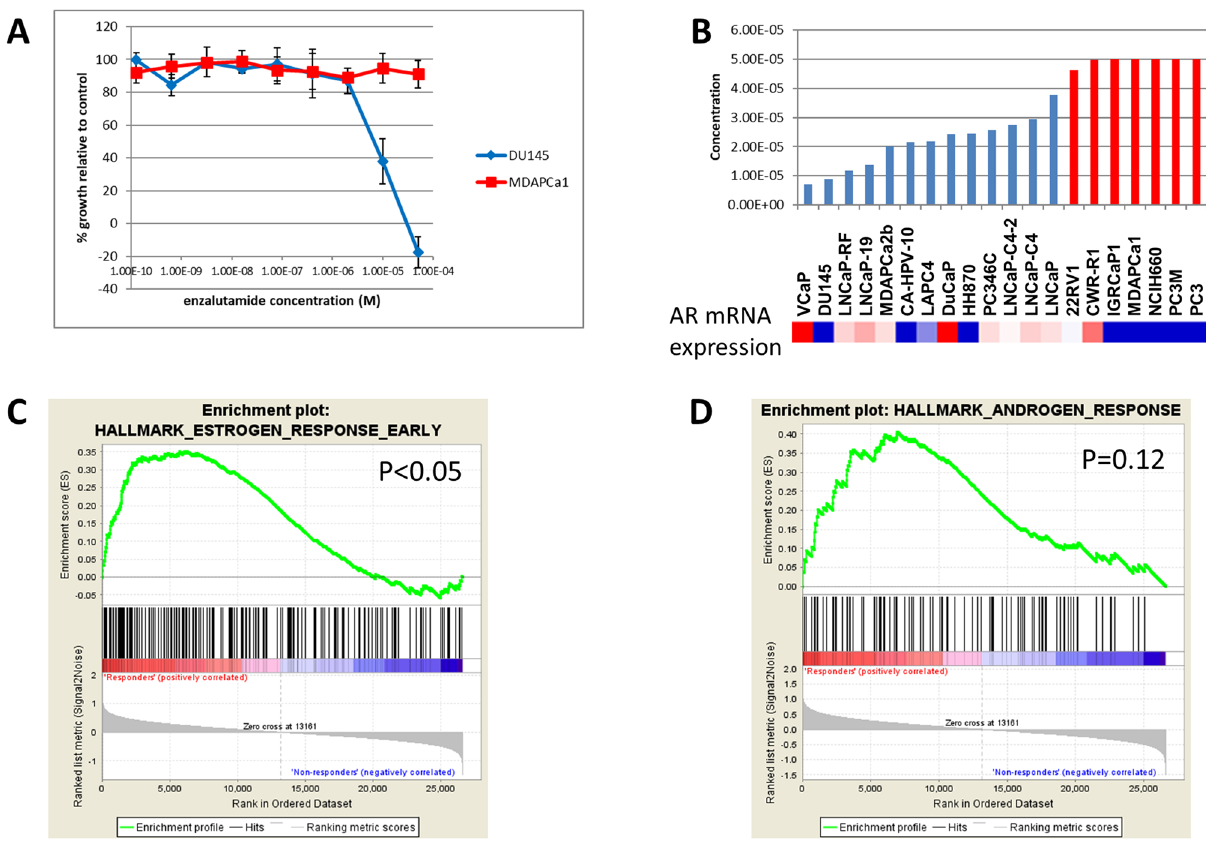
Figure 3. Enzalutamide response in the prostate cancer cell line panel. ( A ) Example dose response curves for a responsive (blue, DU145) and non-responsive (red, MDAPCa1) prostate cancer cell line. Error bars are +/− standard deviation of triplicate measurements. ( B ) GI50 values for each of the cell lines divides the samples into responsive (blue) and non-responsive (red) clusters. Lower bars represent lower doses of drug required to inhibit growth by 50%. For non-responsive lines, GI50 values were set to maximal dose tested. ( C,D ) GSEA plots for Estrogen and Androgen response elements show differences between enzalutamide responders and non-responders. The association is significant for ER associations ( p < 0.05) but fails to reach significance for AR ( p =